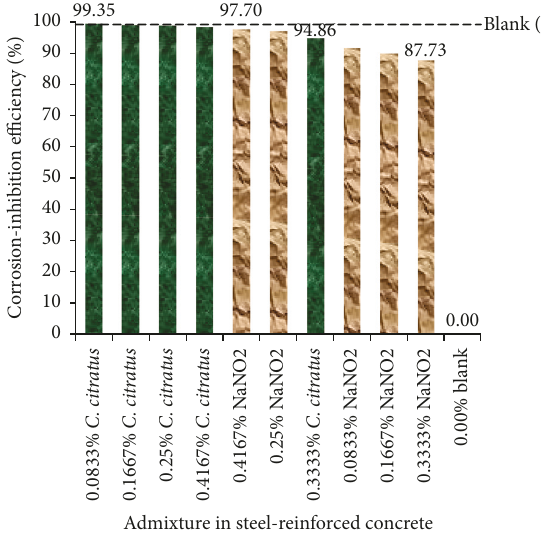
Figure3:Rankingofinhibitionefficiencyperformanceof C.citratus leaf-extract and NaNO 2 admixtures on reinforcing-steel corrosion in concrete samples